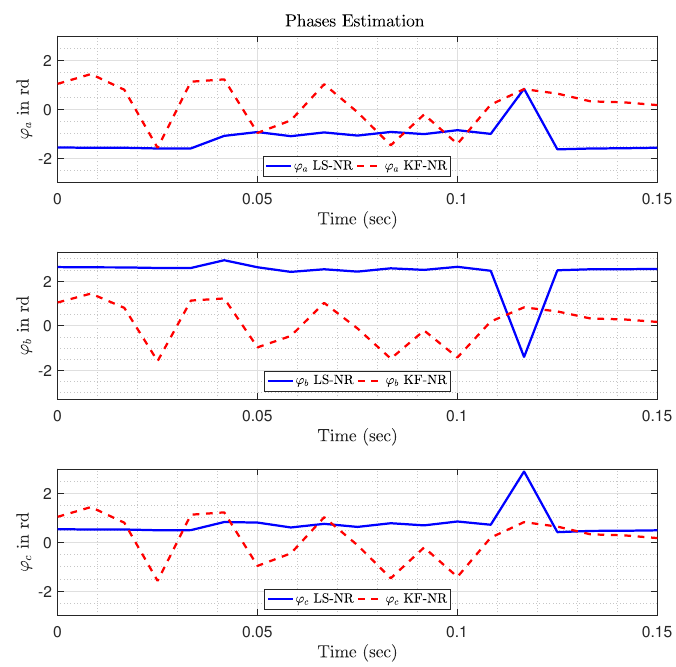
Figure 7. Phases variation of phasors: comparison between LS and KF using NRA estimations (event 2911).